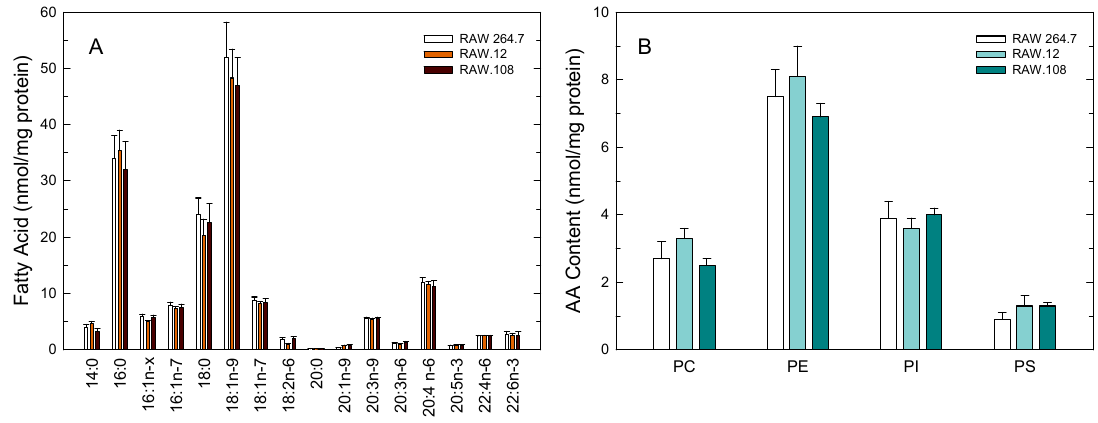
Figure 1 . Phospholipid fatty acid composition of RAW 264.7 cells and plasmalogen-deficient variants: ( A ) The profiles of major fatty acids in RAW 264.7 cells (open bars), RAW.12 (light brown), and RAW.108 (dark brown) were determined in the phospholipid fraction by GC-MS after converting the fatty acid glyceryl esters into fatty acid methyl esters. 16:1 n -x denotes a mix of the n -9 and n -10 isomers, which elute together. ( B ) The phospholipid classes of RAW 264.7 cells (open bars), RAW.12 (light turquoise), and RAW.108 (dark turquoise) were separated, and their AA content was determined by GC/MS. Results are shown as means ± S.E.M. (n = 3).